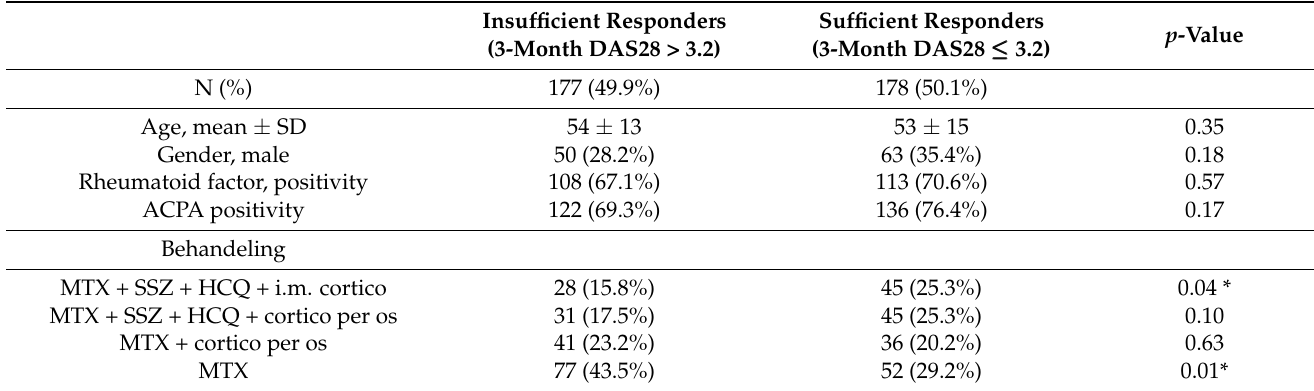
Table 2. Baseline comparisons between sufficient and insufficient responders.